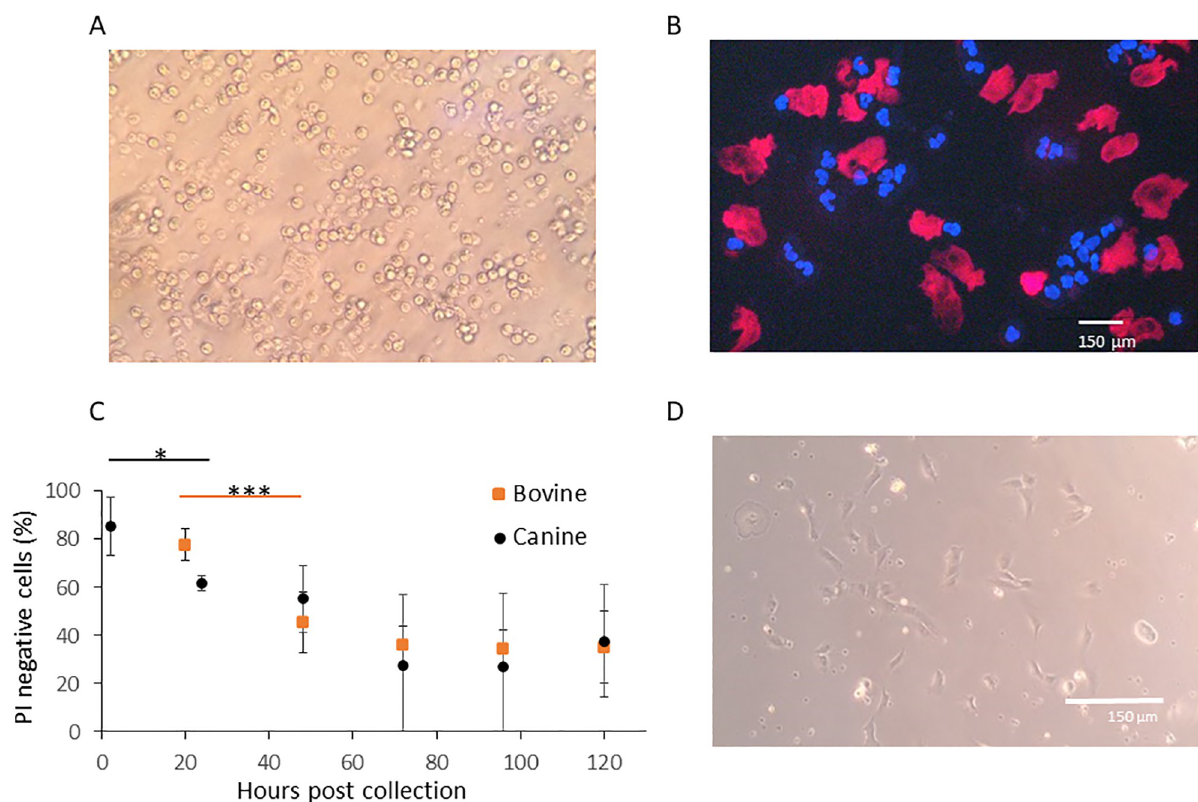
Fig 2. Canine Urine and UDCs A) Urine cells following isolation. B) Cellular morphological variation of large and small cells and integrity staining utilizing Propidium Iodide (red) and Hoechst 33342 (blue). Red stained cells indicate membrane permeability and thus non-viable cells; blue stain illustrates nuclei with intact membranes. C) Urine cell integrity indicate by Propidium iodide negative stain over time stored at 4˚C ( � p < 0.05, ��� p <